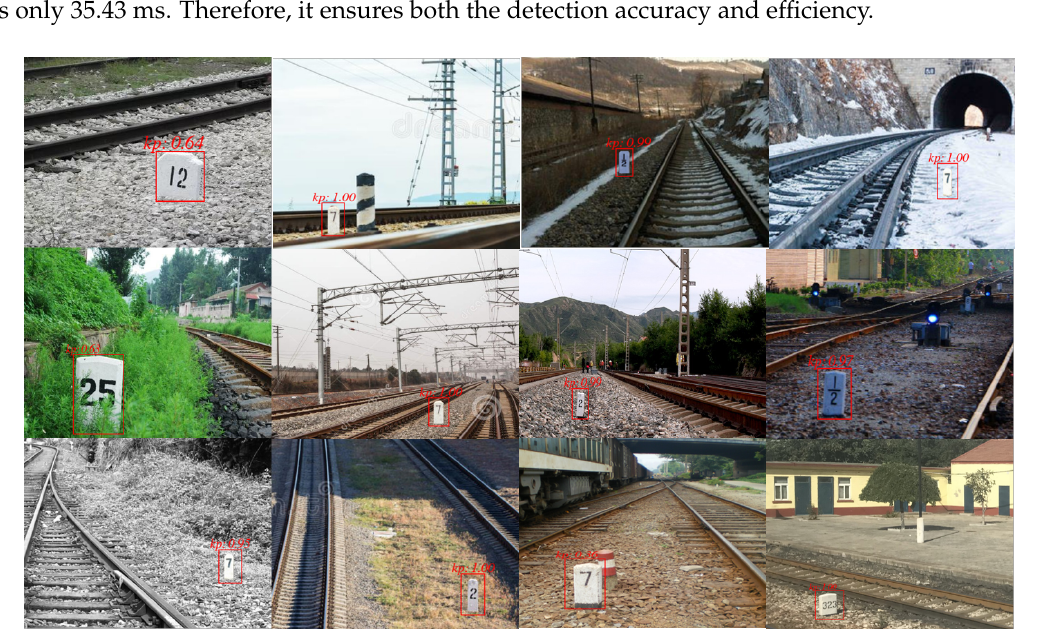
Figure 9. Detection and location results of kilometer post